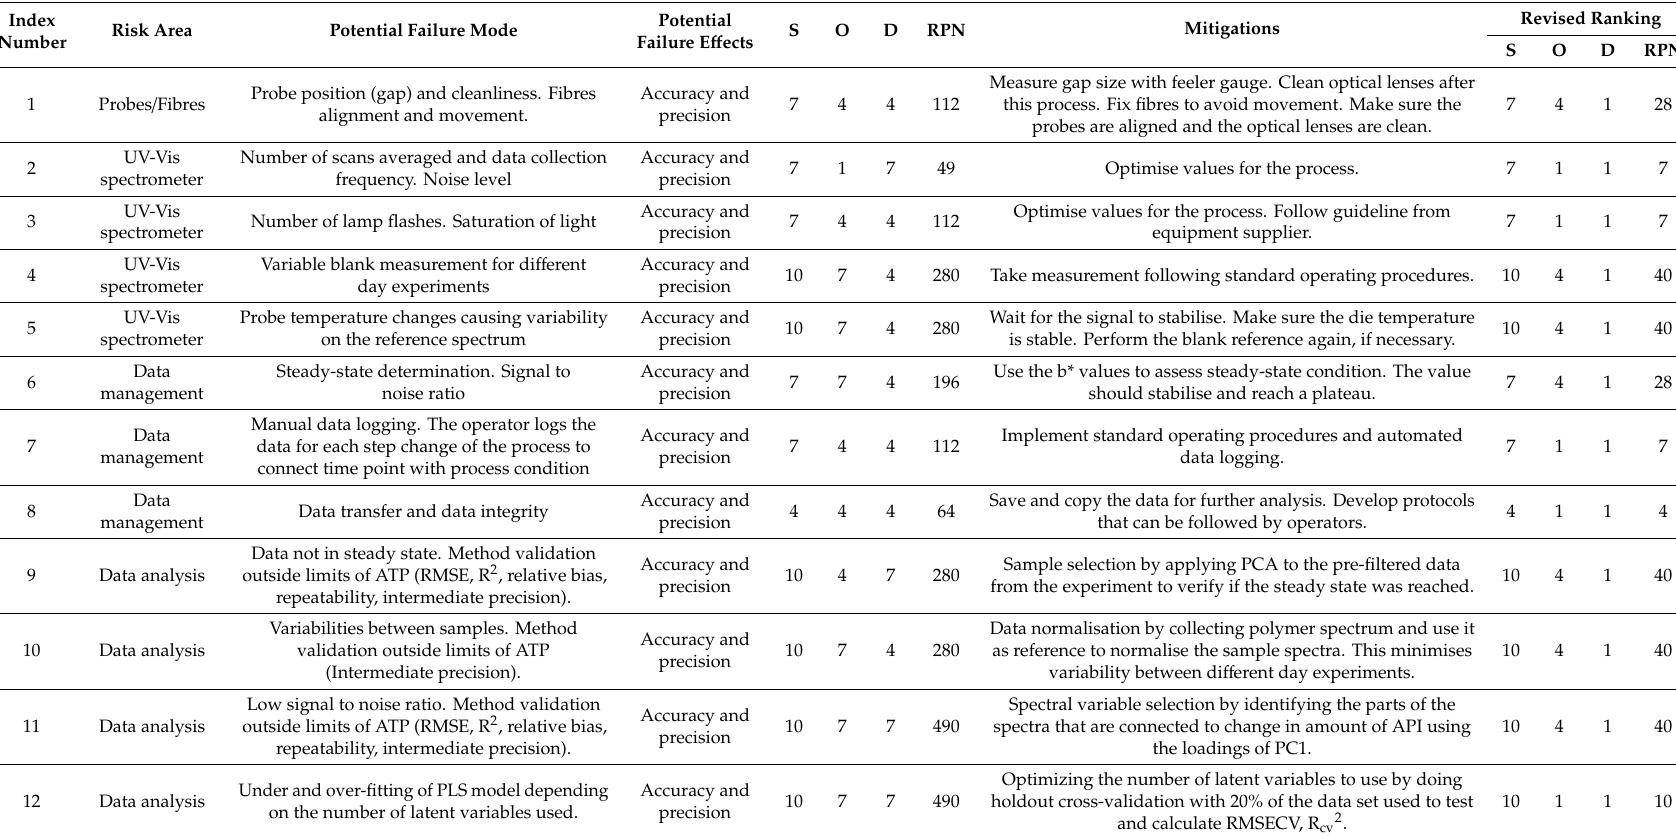
Table 2. FMEA for the analytical procedure. The ATP performance characteristic a ff ected are specificity, accuracy and